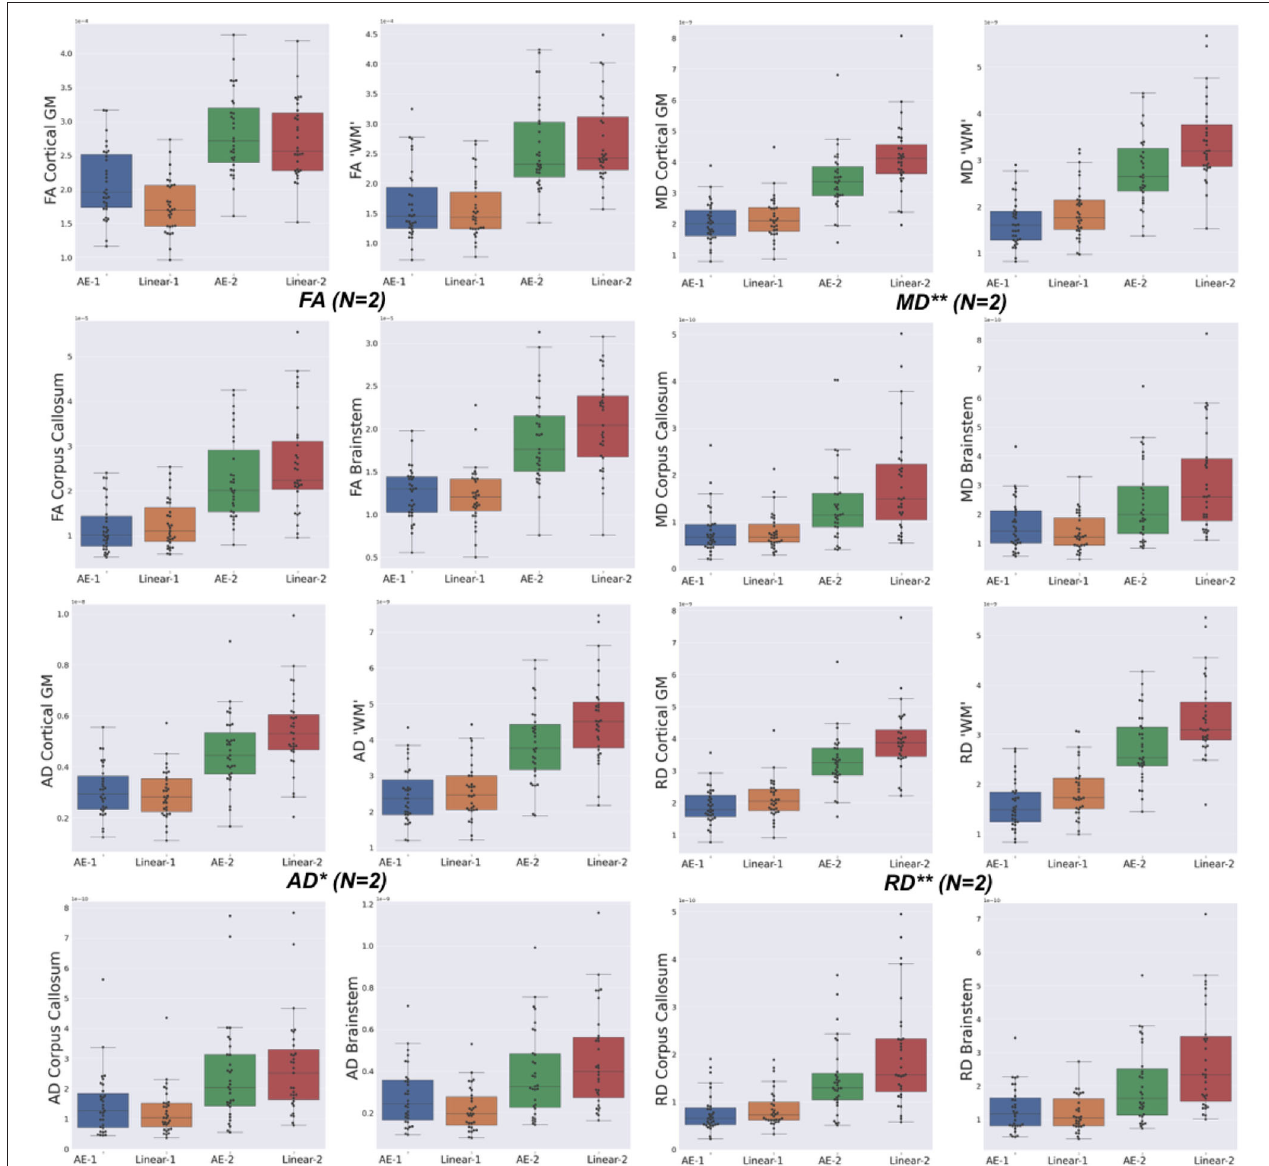
FIGURE 7 | Mean squared error (MSE) with respect to the GT of the best baseline method (Linear) and the autoencoder (AE) enhancement in the different brain structures [Cortical Gray Matter (GM), White Matter (WM), Brainstem, and Corpus Callosum] for each diffusion tensor map (FA, MD, AD, and RD) for one slice removal ( N = 1) and two slices removal ( N = 2). Comparing the DTI maps of the merged brain region labels, we found that the AE-2 significantly outperforms other conventional methods for MD, RD, and AD. (Paired Wilcoxon signed-rank test: ** p < 0.0018 and * p < 0.017).